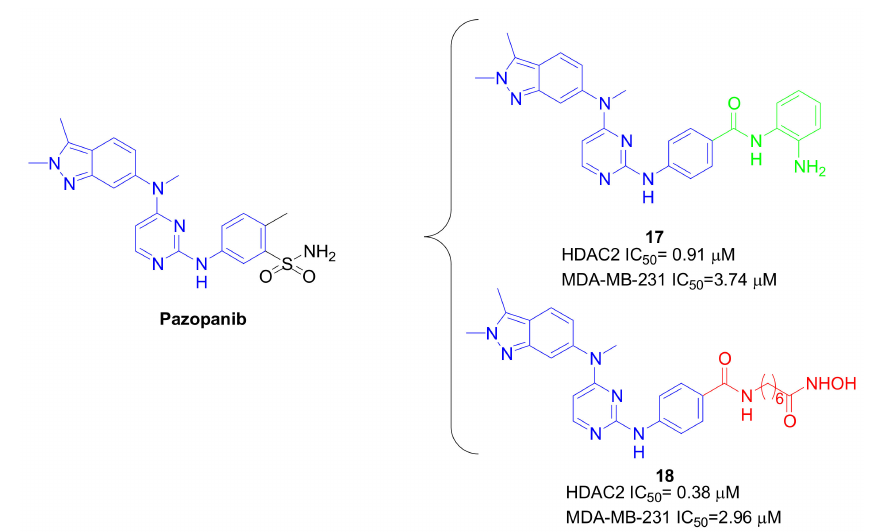
Figure 12. Chemical structures and biological activity of compounds 17 and 18